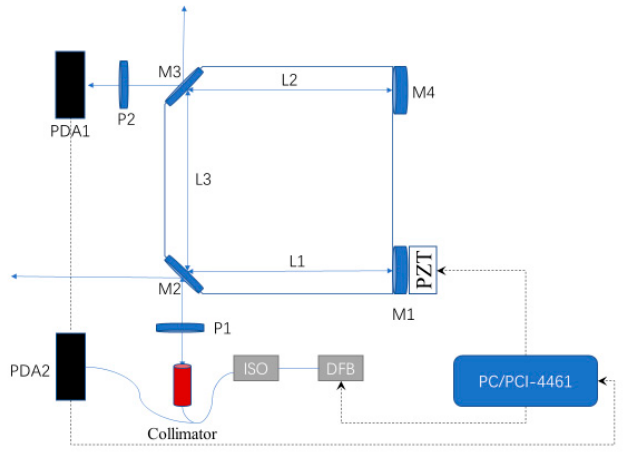
Figure 1. Structure diagram of a folded-cavity enhanced absorption spectroscopy experimental setup. M1–M4: mirrors; DFB: distributed feedback; PDA: photodetector; PZT: piezoelectric ceramic transducer; ISO: optical isolator; P1, P2: line polarizer.